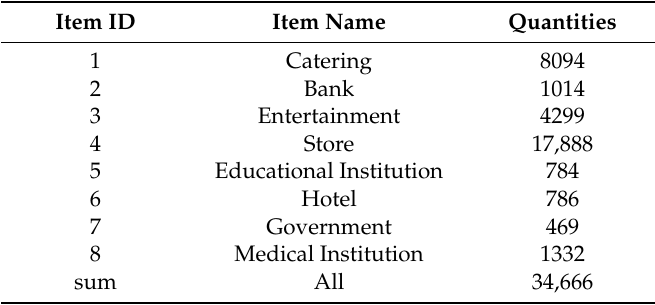
Table 1. Items of urban shops in Luoyang